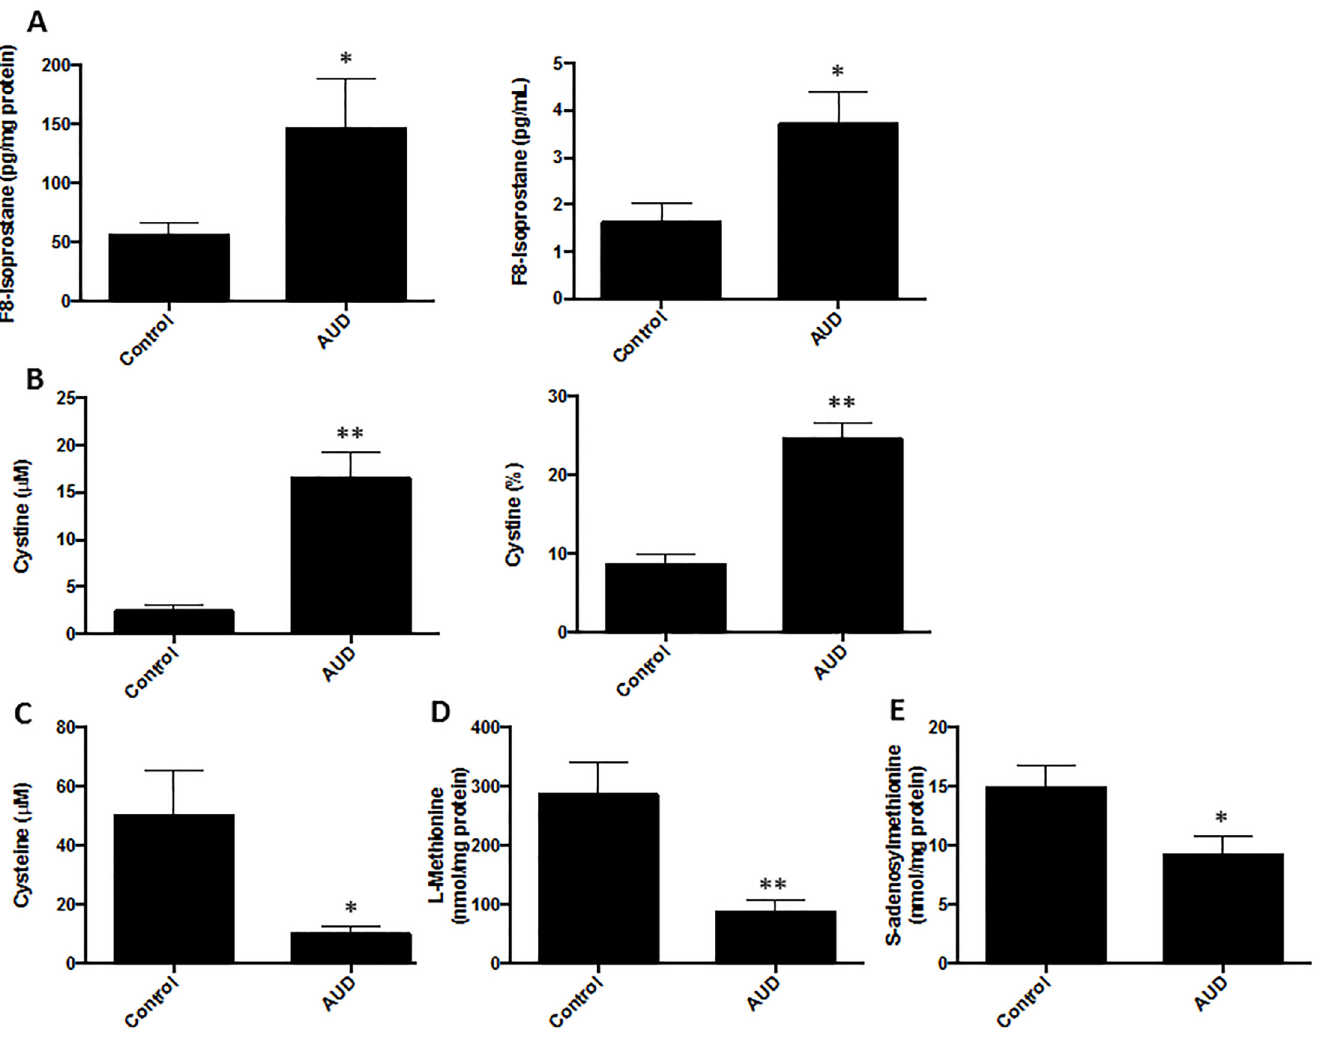
Fig 1. Oxidative stress markers are elevated in the BALF of AUD subjects. A. F8-Isoprostane in BALF was quantitated by an ELISA and expressed relative to the BALF protein concentration or on a per mL basis. B. Cystine was measured in the BALF by HPLC following dansylation and the concentration is expressed in μ M or as a percentage of the total pool (cysteine + cysteine). C. After dansylation, cysteine was measured in the BALF by HPLC and the concentration expressed as μ M. D. Methionine (nmol/mg BALF protein) was measured by HPLC following derivatization with the AccQ.Fluor reagent. E.